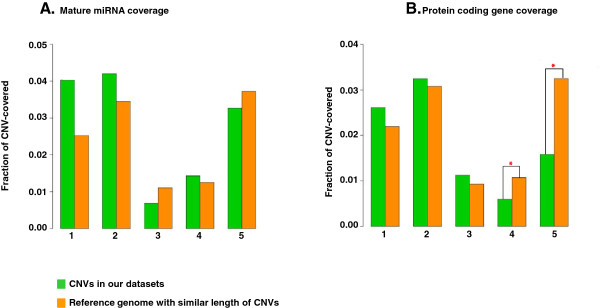
Genomic coverage of miRNA (A) and protein coding genes (B) in different CNV subgroups. The fraction was defined as observed number of miRNA (or protein coding genes) in each CNV group divided by the total miRNAs (or total number of protein coding genes) in human genome. The miRNA or gene fraction in CNVs was compared to the miRNA or gene fraction in the reference genome which was generated by extracting random DNA fragments with similar length to the respective CNVs 1000 times from human genome. * Indicates p < 0.05 (a Wilcoxon signed-rank test). 1: De novo CNVs; 2: DECIPHER CNVs; 3: Familial CNVs; 4: Common CNVs from controls; 5: Common CNVs from cases.